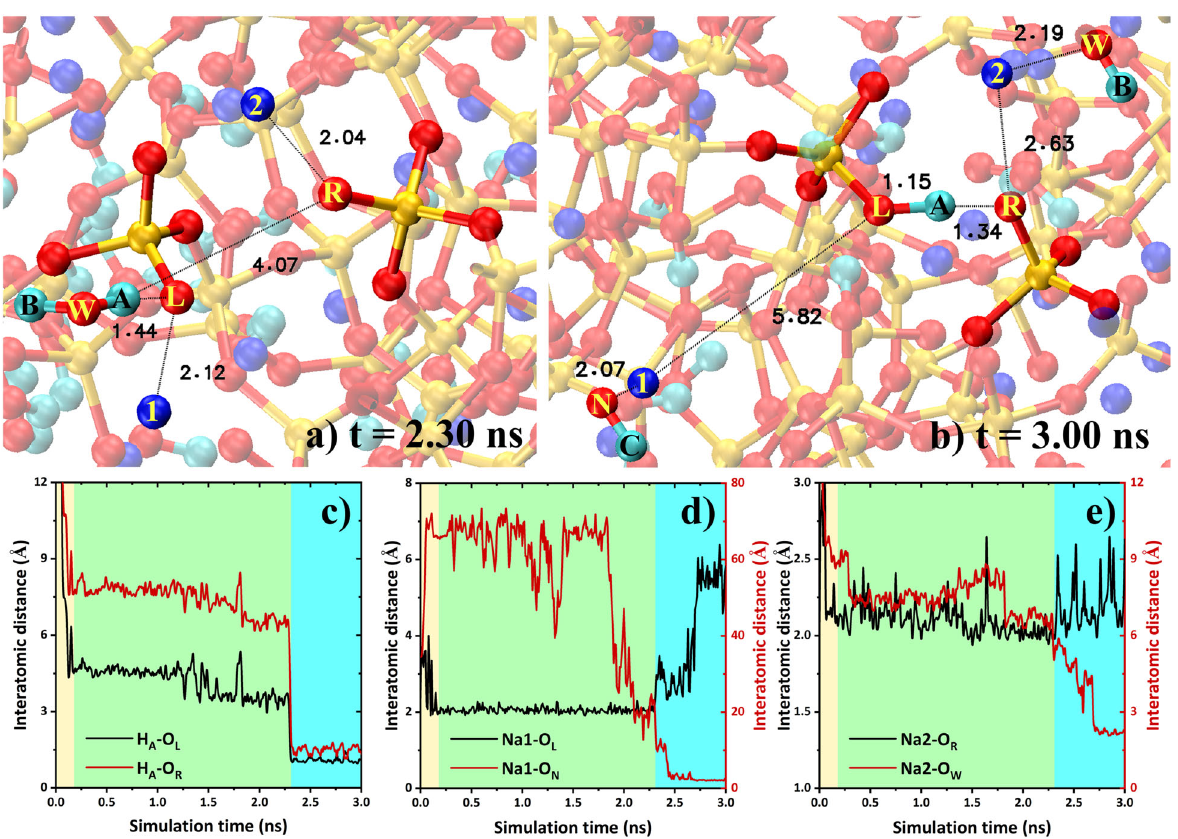
Fig. 8 Ion-exchange mechanism during the adjacent-exchange silanol re-formation process. a , b The snapshots of involved atoms/ions in adjacent-exchange silanol re-formation at 2.30 ns (during ion-exchange process, beginning of cyan region) and 3.00 ns (after the ion- exchange process, end of cyan region), where 1 and 2 are sodium ions, L and R represent two non-bridging oxygens belonging to two SiO 4 tetrahedra, W and N are oxygen atoms belong to water molecule, A, B, and C represent hydrogen atoms involved in the reaction. c – e Distances between the monitored ions (H A , Na1, and Na2) and oxygen atoms (O L , O R , O W , and O N ) versus the simulation time,